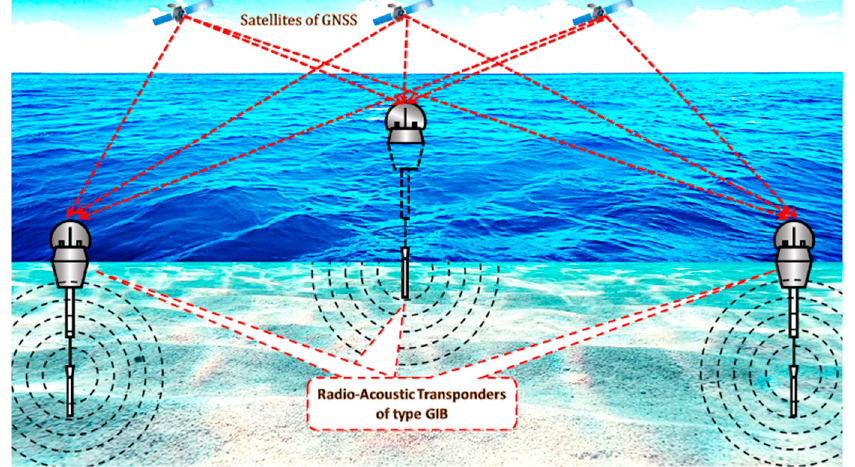
Figure 10. The main idea of LNSS.